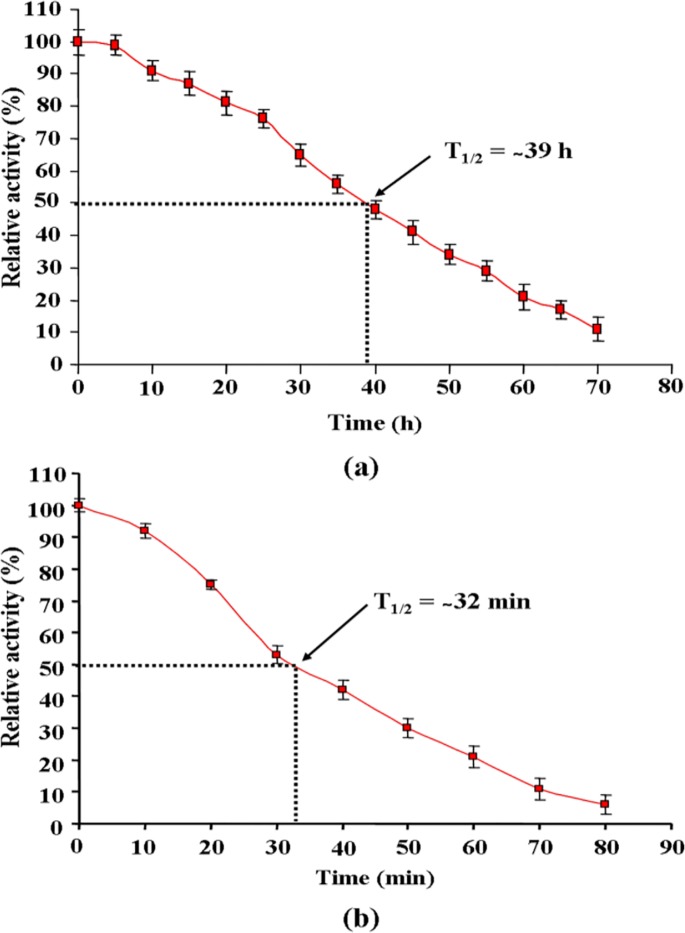
Physiological properties of asparaginase purified from E. cloacae.In vitro
(a) serum and (b) trypsin half life. Asparaginase was incubated with serum and trypsin, separately and relative activity was measured on the basis of the highest activity of purified asparaginase as 100%. Each value represents the mean ±SD for three determinations.